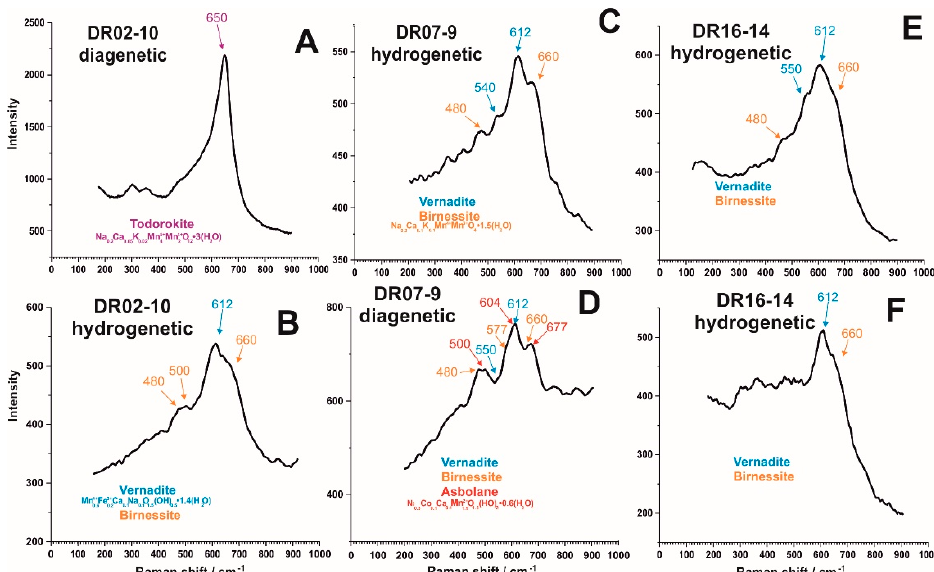
Figure 7. (A – F ) micro-Raman spectra in different spot analysis made on studied samples; ( A ) typical peak at 650 cm − 1 of 10Å todorokite and ( B ) 612 cm − 1 peak of vernadite partially masked by peaks of birnessite at 480, 500 and 660 cm − 1 ; ( C ) 480 and 660 cm − 1 peaks of birnessite and 550 and 612 cm − 1 peaks of vernadite; ( D ) 500, 604 and 677 cm − 1 peaks of asbolane overlapping with vernadite and birnessite; ( E , F ) 480, 660 cm − 1 and 550 and 612 cm − 1 peaks belonging to birnessite and vernadite.